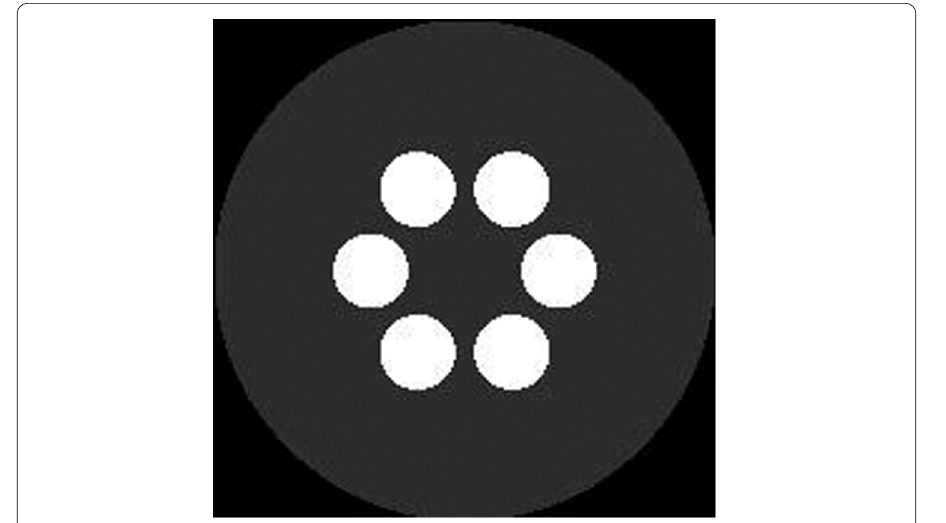
Figure 2 An incoming beam consisting of six spots arranged over a circle